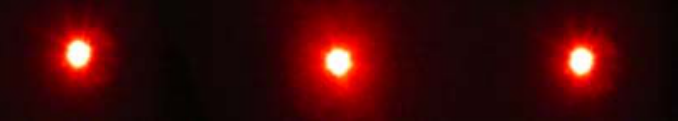
Figure 6. Optical reconstruction of the diffraction pattern from a holographic grating built from Figure